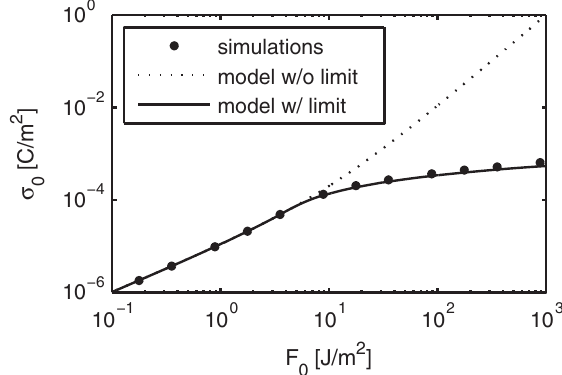
FIG. 2. Peak surface charge density versus peak laser fluence, simulated using